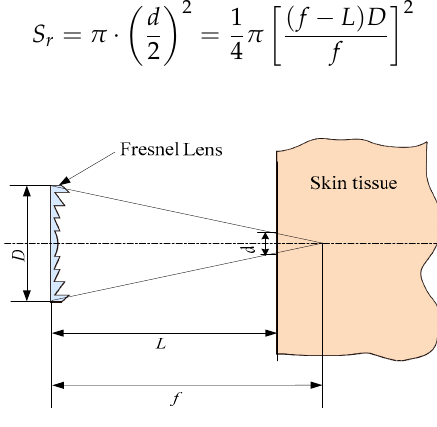
Figure 3. Parameters of Fresnel lens.